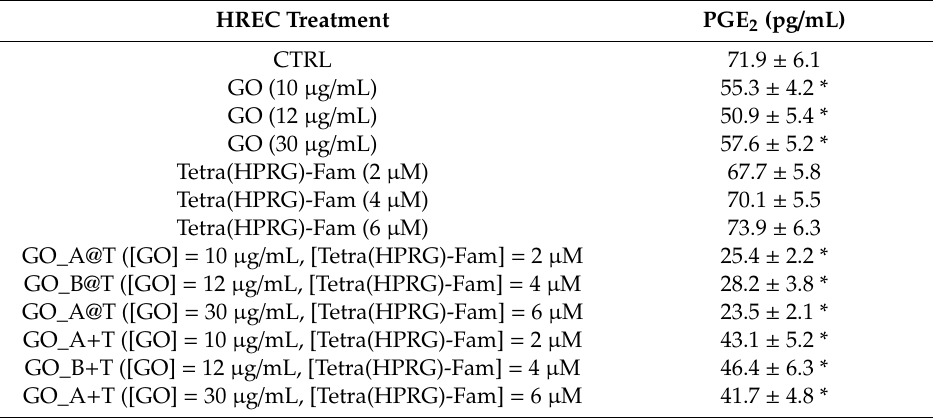
Table 2. PGE 2 production in human retinal endothelial cells (HREC), after di ff erent treatments. Values (means ± SEM) are from three independent experiments ( n = 3). Student’s t -test used to compare PGE 2 production in all experimental conditions. * p < 0.01 vs. control